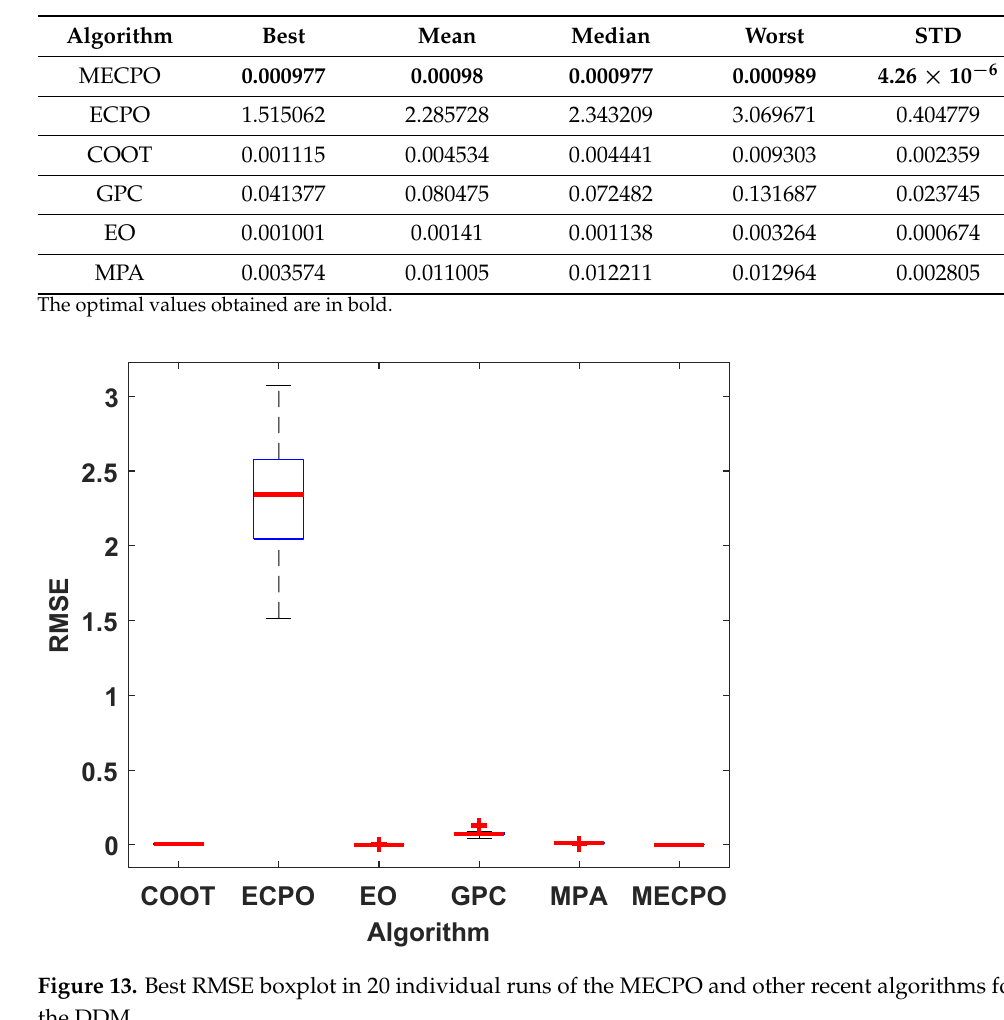
Table 10. Statistical results of the MECPO technique and other recent techniques in the case of the DDM.